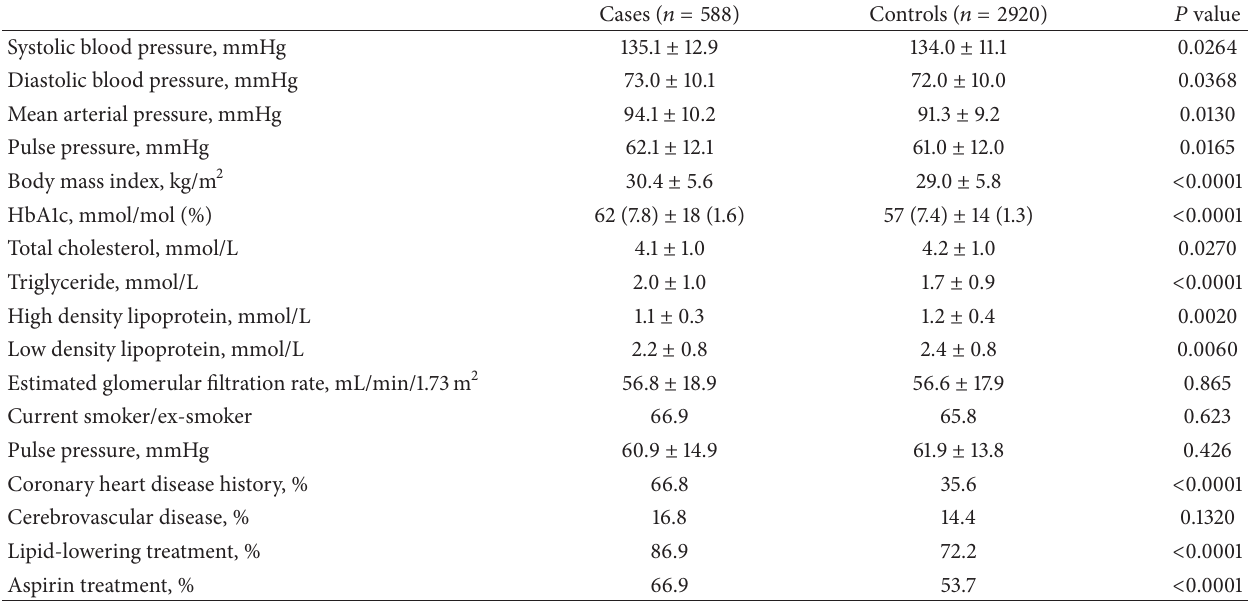
Table 1: Characteristics of patients with cardiovascular hospitalisation and matched